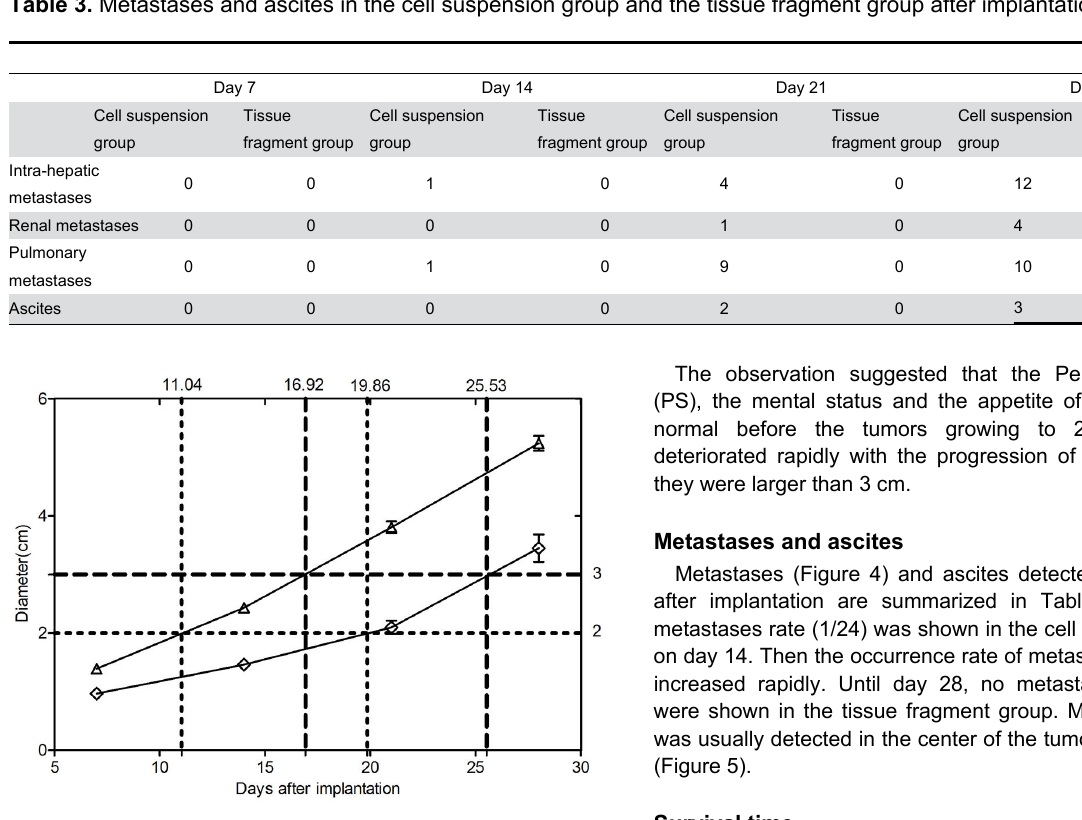
Table 3. Metastases and ascites in the cell suspension group and the tissue fragment group after